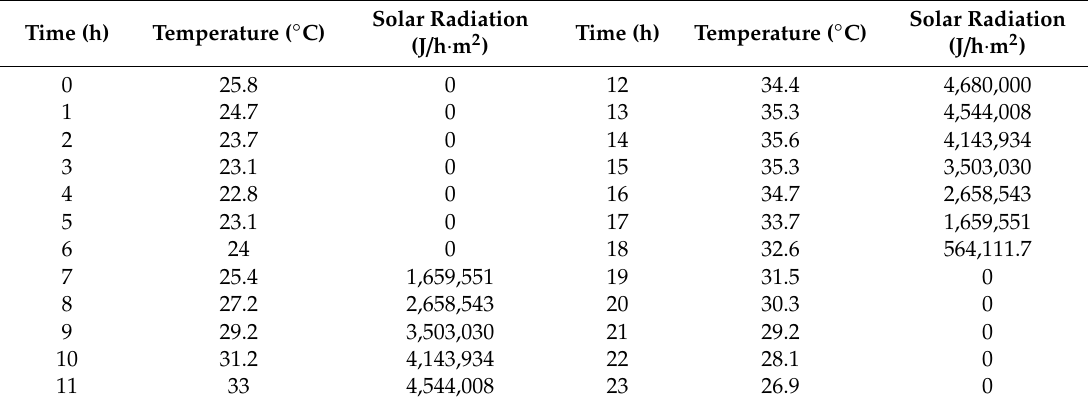
Table 5. Temperature curve and solar radiation curve of a certain day in Shijiazhuang City [25] Time